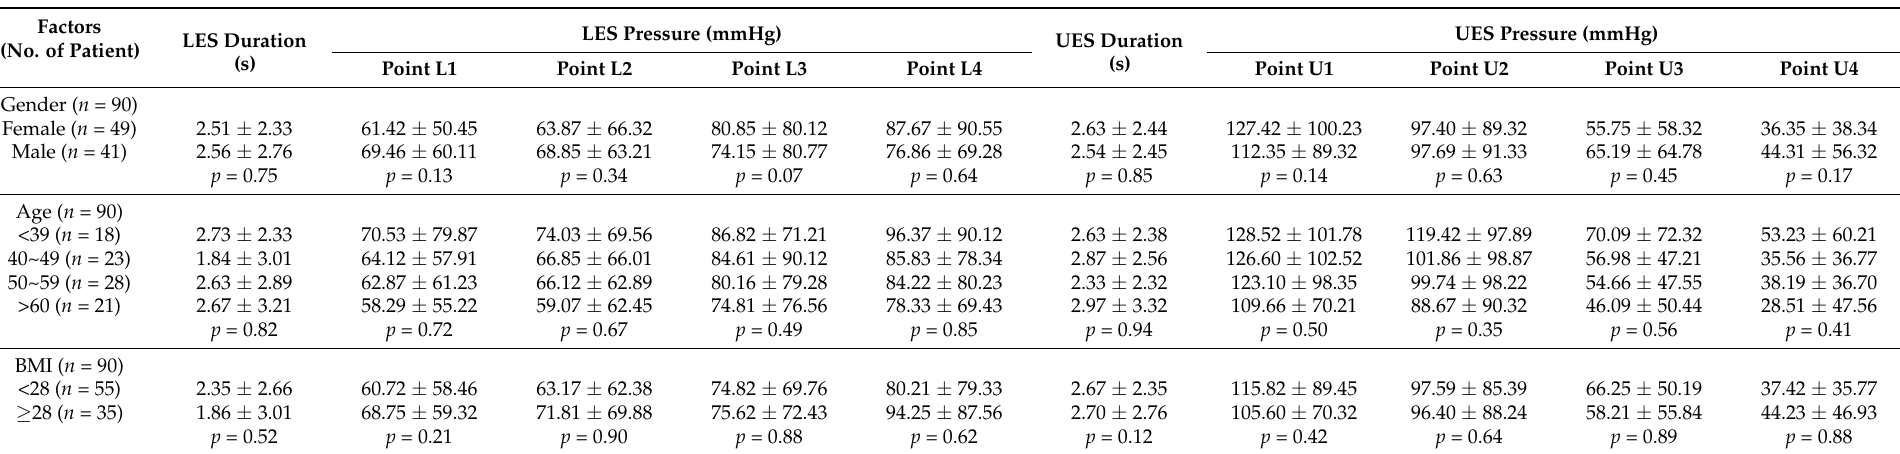
Table 4. Comparison of pressure of different LES levels across gender, age, and